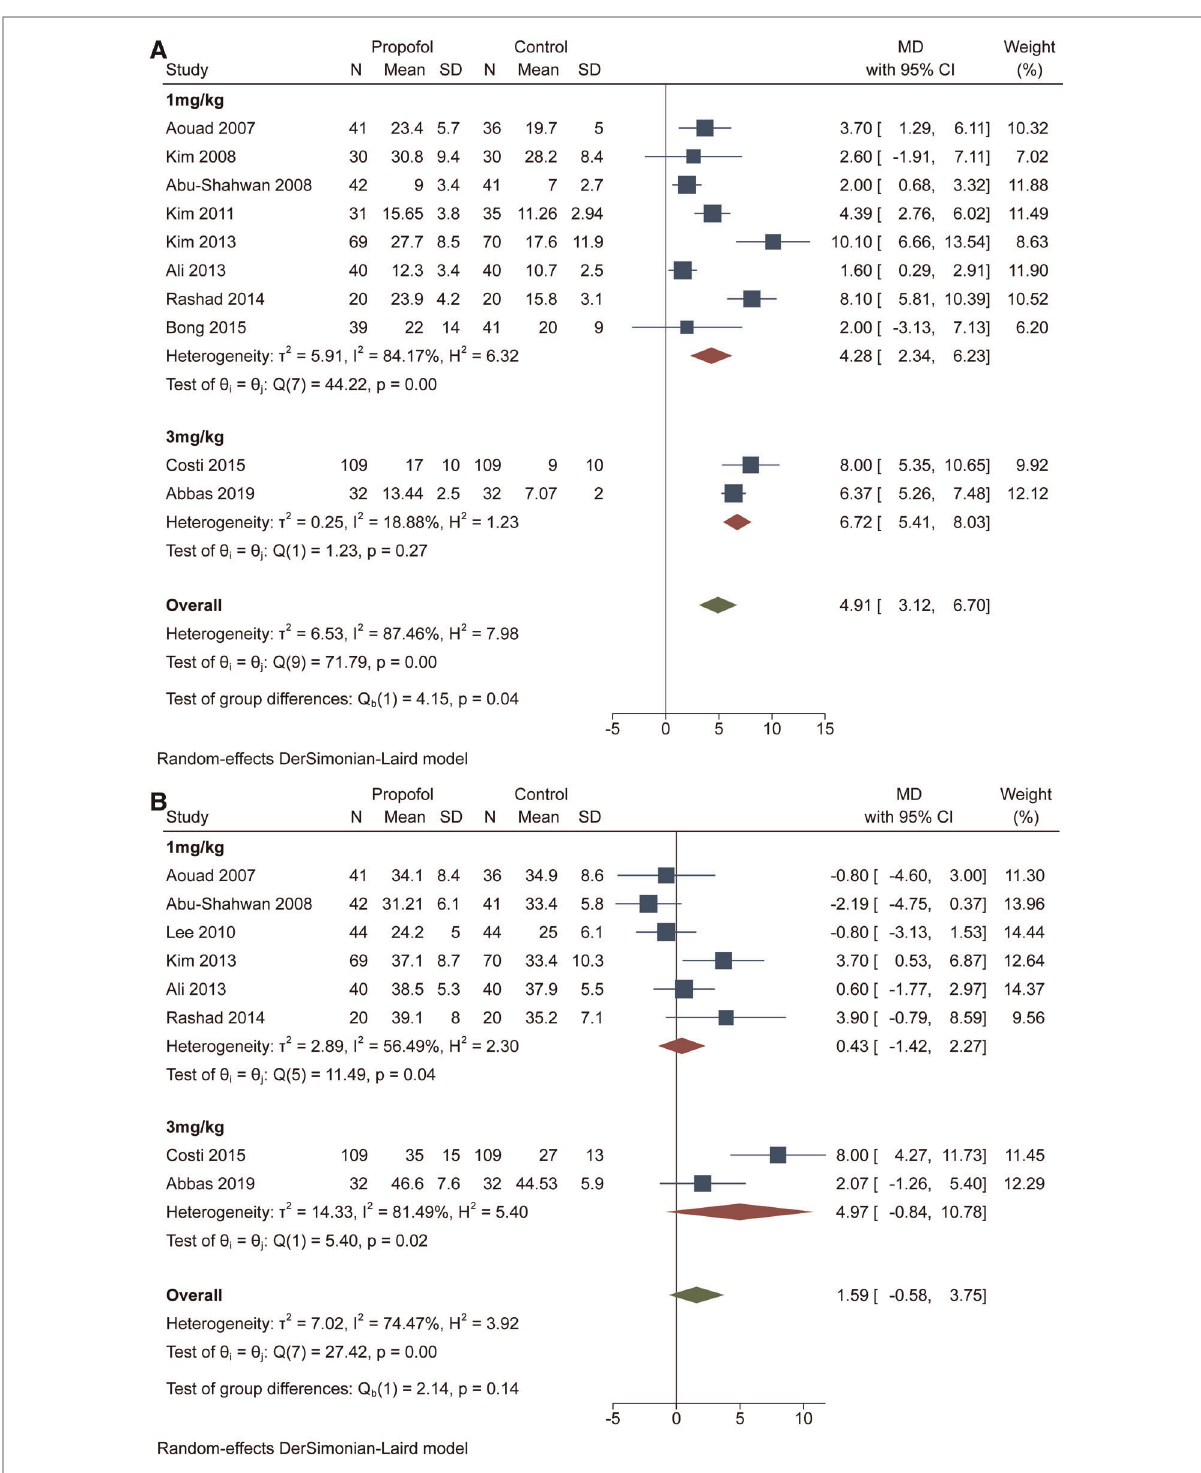
FIGURE 4 Subgroup analysis for recovery time based on the dose of propofol. ( A ) subgroup forest plot for awakening time. ( B ) subgroup forest plot for PACU